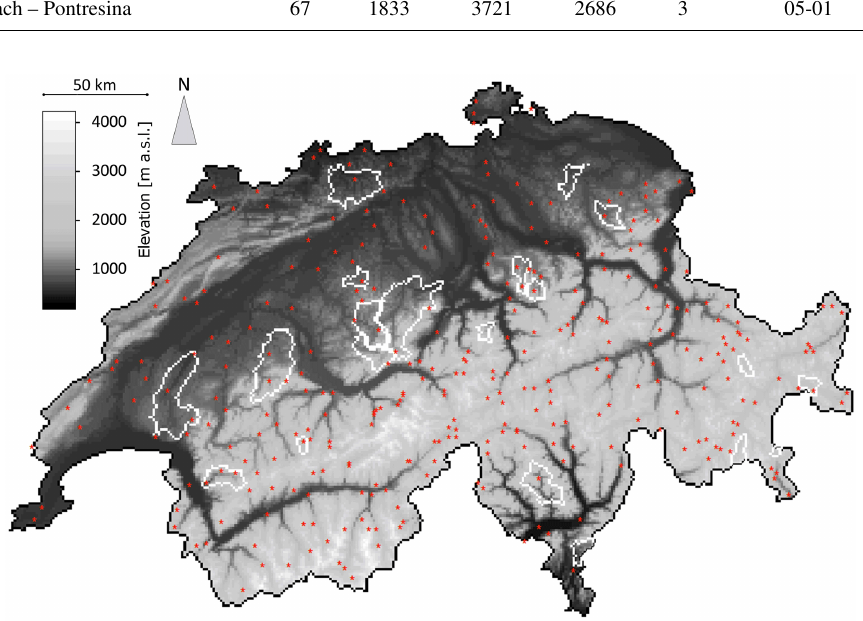
Figure 1. Locations of snow observation stations (red stars) and 20 studied catchments (white border lines) in